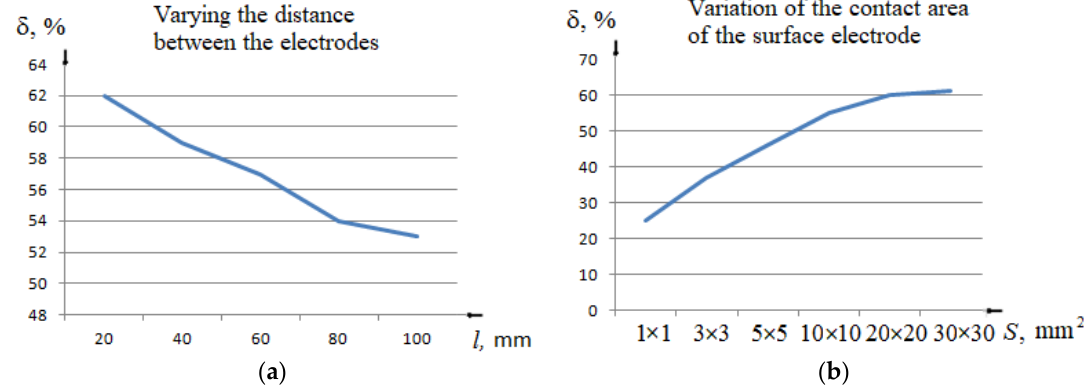
Figure 3. The result of sensitivity analysis of electrical impedance change due to: ( a ) variation of the distance between electrodes, ( b ) the size change of the attached electrode.